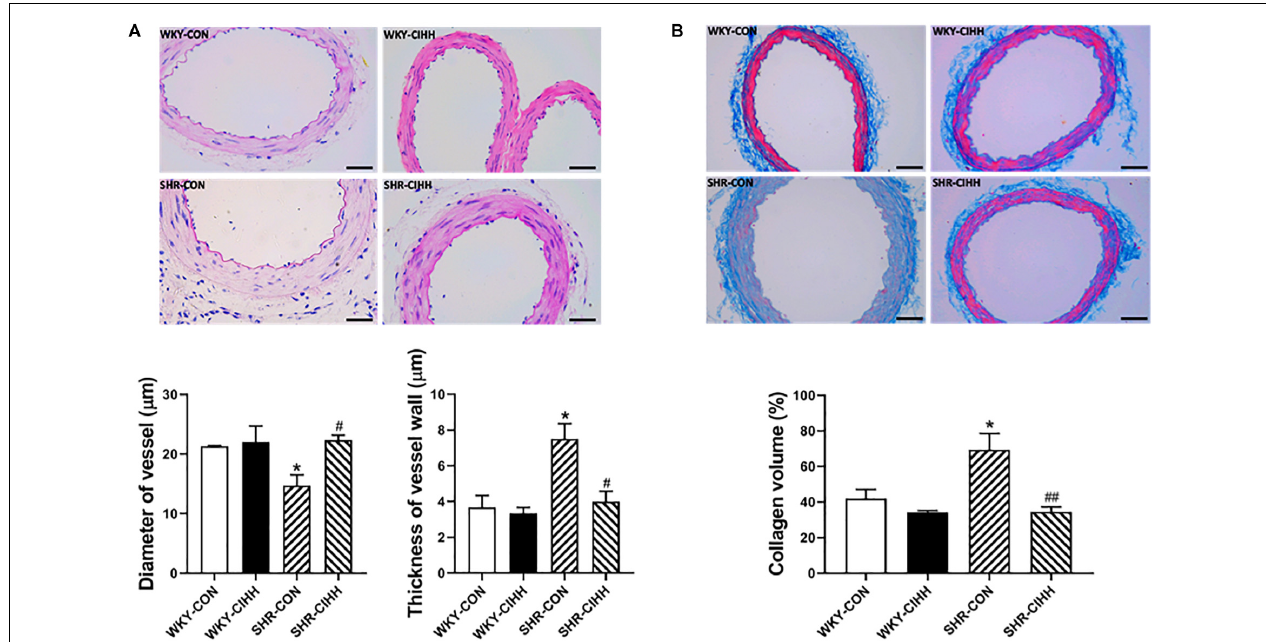
FIGURE 8 | Effect of chronic intermittent hypobaric hypoxia (CIHH) on vascular structure and collagen volume in the mesenteric arteries of spontaneously hypertensive rats (SHRs). (A) Representative HE staining and summarized vessel diameter and vessel wall thickness data in the different groups: Scale bar 50 µ m, magnification × 400, (B) representative and summarized Masson’s staining data: Scale bar 50 µ m, magnification × 400, Data are expressed as mean ± SEM; n = 5 for each group. SHR-CON: control SHR; SHR-CIHH: SHR with CIHH; WKY-CON: control WKY rats; WKY-CIHH: WKY rats with CIHH. * P < 0.05 vs. WKY-CON, # P < 0.05, ## P < 0.01 vs. SHR-CON (one-way